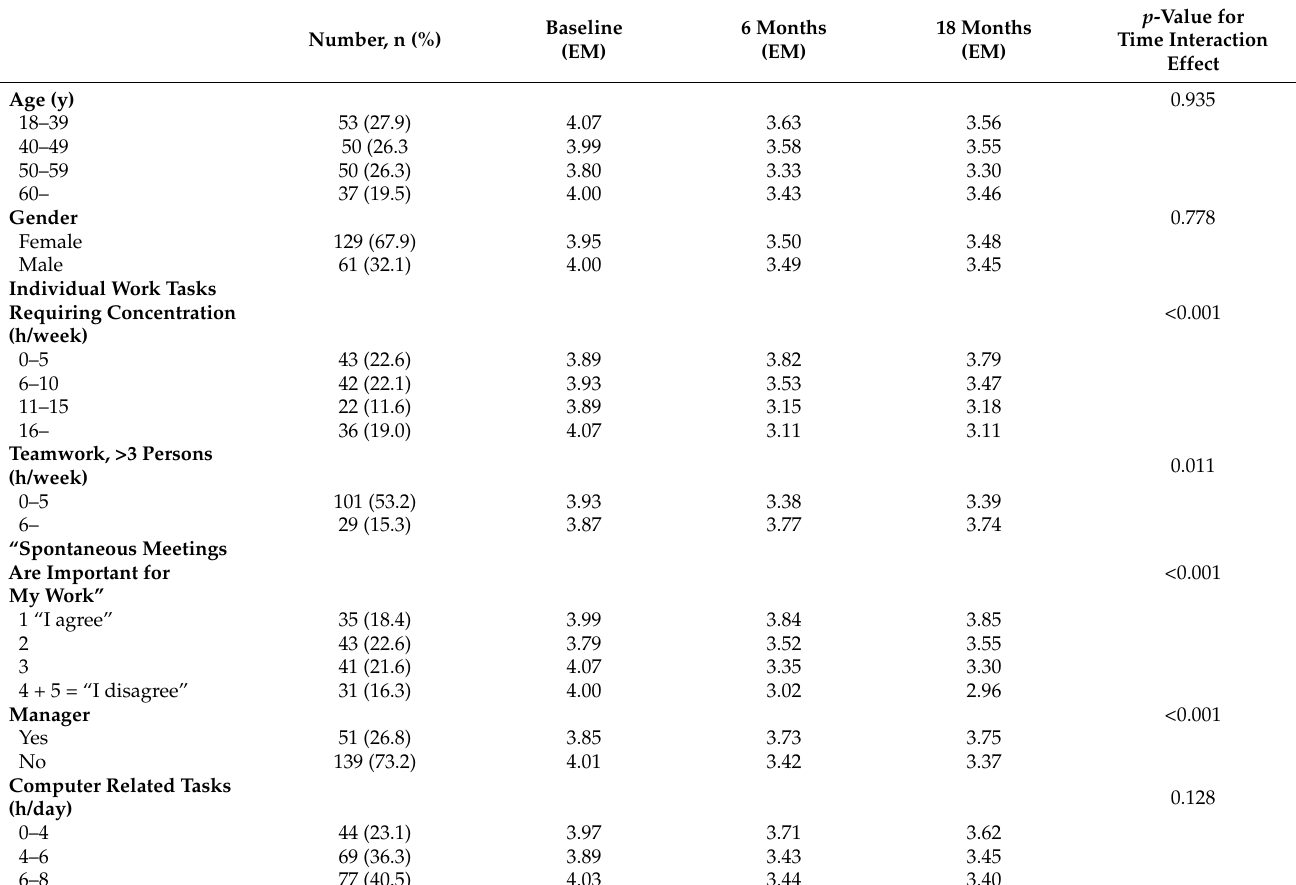
Table 4. Perceived productivity in the activity-based flex office (AFO) in relation to age, gender and work characteristics presented as estimated means (EM). Change in productivity over time is presented as time interaction effect. p -Value for Baseline 6 Months 18 Months Time Number, n (%) (EM) (EM) (EM)